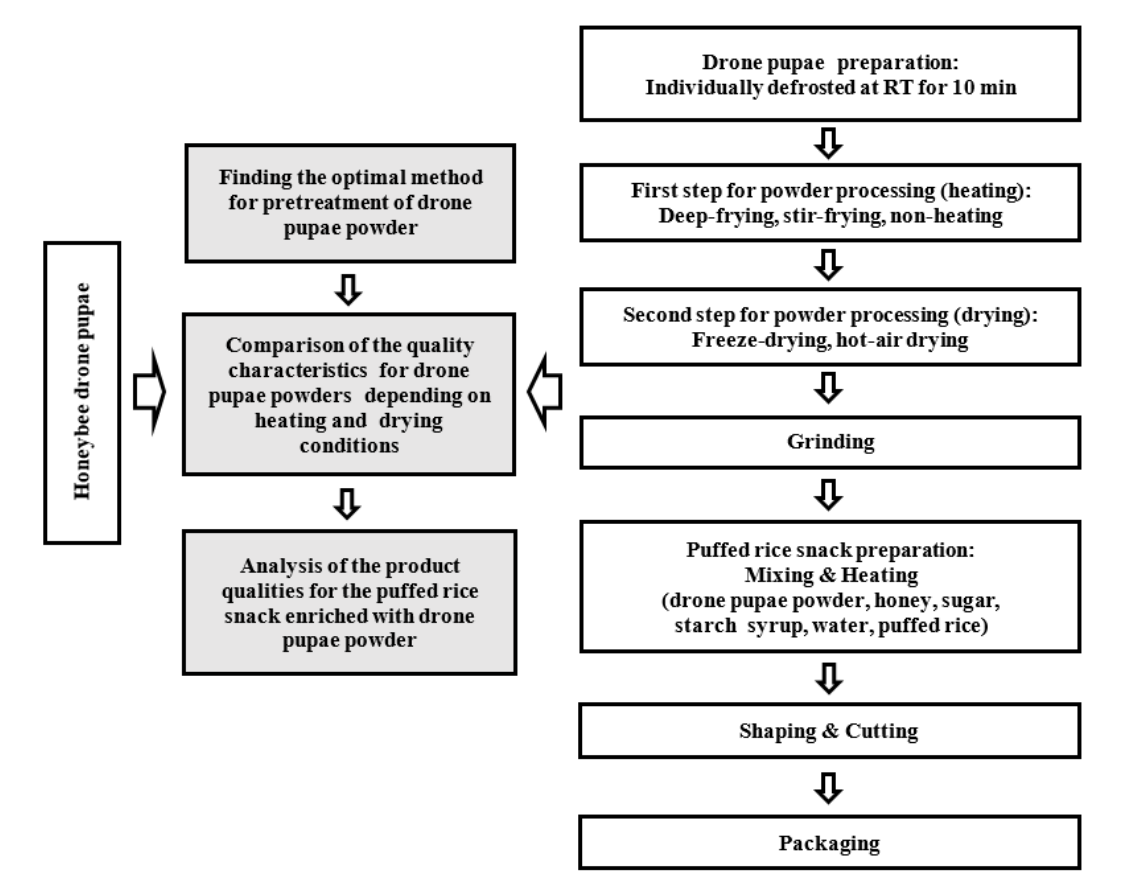
Figure 1. Schematic design of the drone pupae powder and the developed product research (RT; room temperature; 15–20 °C).